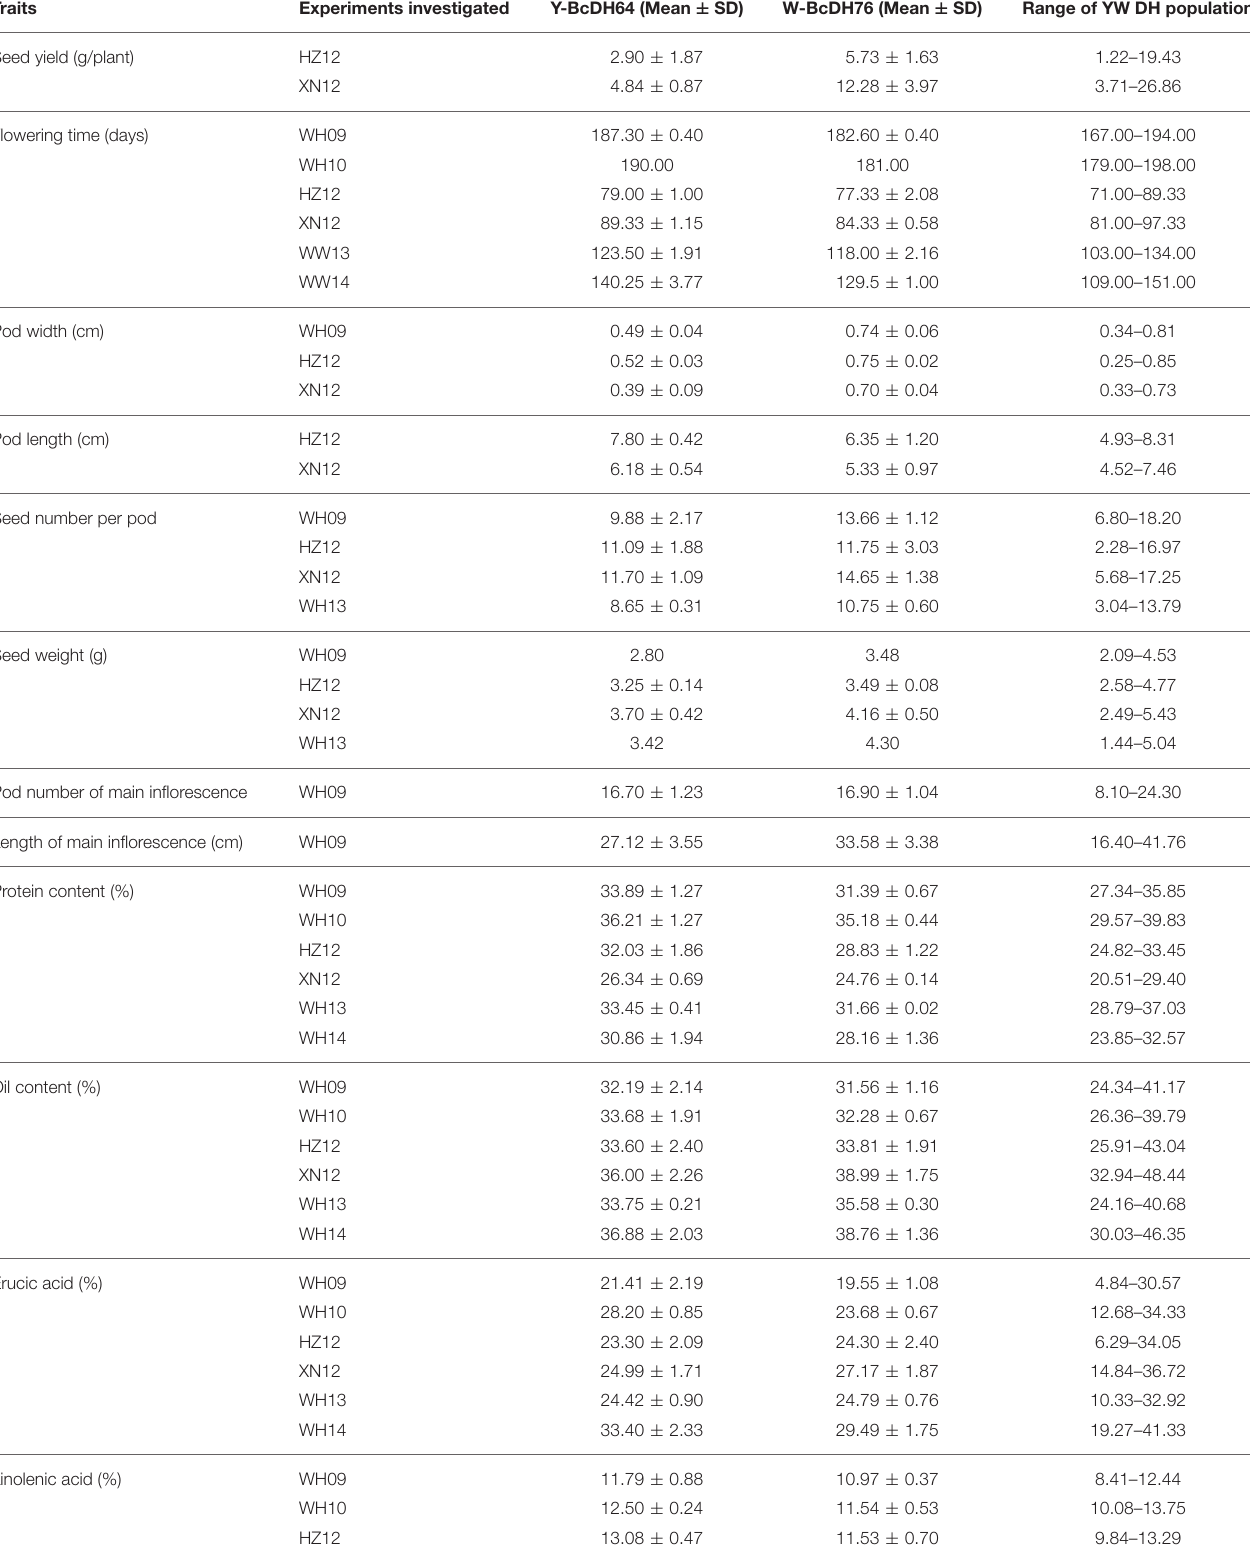
TABLE 2 | Summary of the phenotypes of the YW DH population and its parents in different experiments.